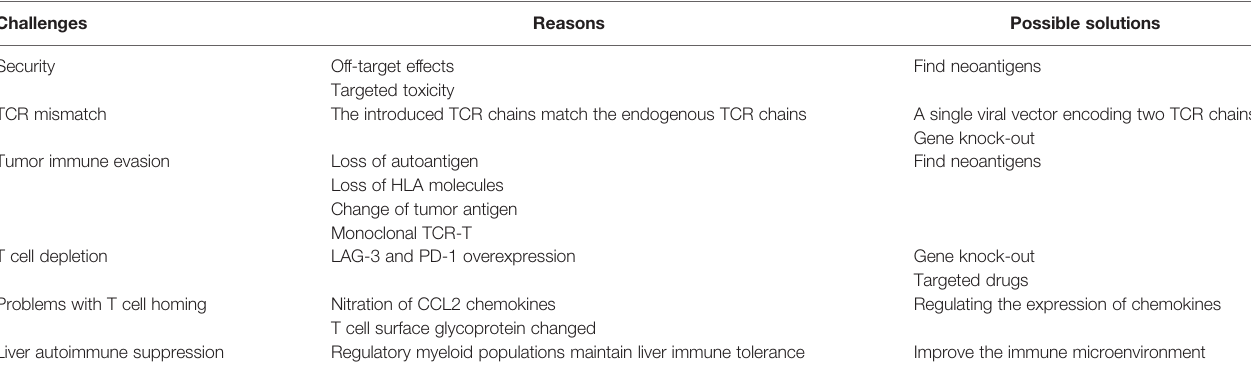
TABLE 2 | Current challenges, reasons and possible solutions of TCR-T induced by T-iPSCs for the treatment of Hepatocellular Carcinoma.